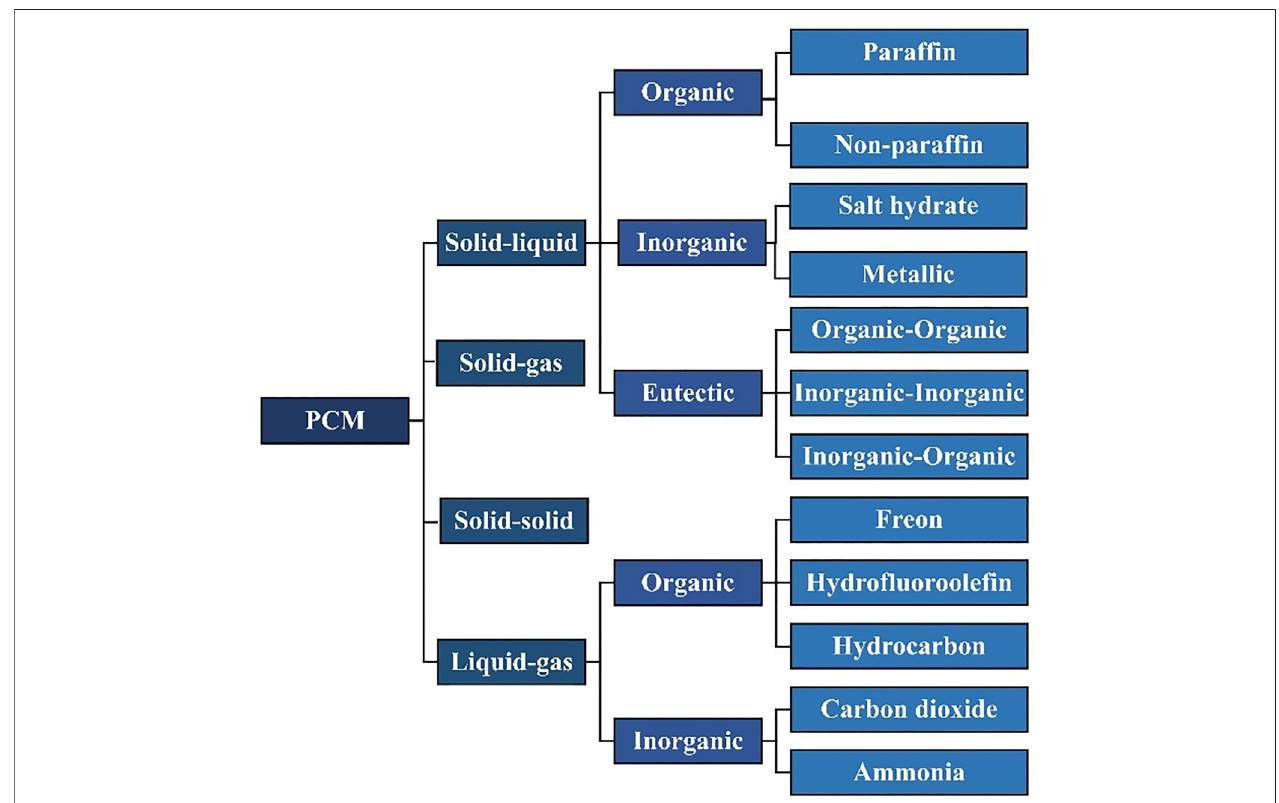
FIGURE 4 | Classi fi cation of PCM. Reproduced with permission (Rathod, 2018). Copyright 2018,